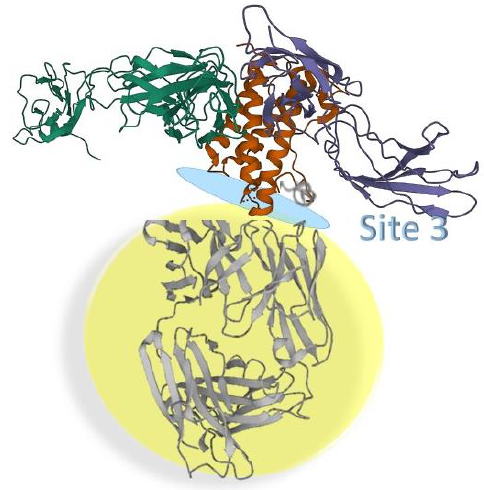
Figure 4. Schematic representation of the binding of OKZ (gray) to the cytokine. The picture is an artifact of the natural trimer with OKZ on site 3 and has the aim to make clearer the positions of different binding sites. Circles render Site 3 (cyan) and the antibody (yellow); the small helix E, up to Site 3 (gray) is pictured. Table 3. List of IL-6 analyzed receptors. For each receptor, the IL-6 helices mainly involved in the binding process are reported, see Figure 2.